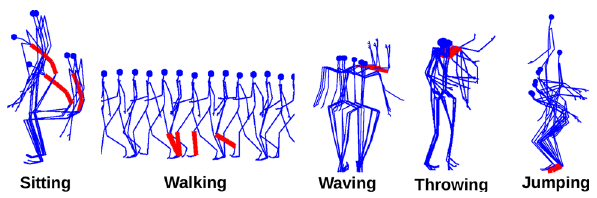
Fig. 9 Visualization of the Abs-filters learned by DACNN on the NTU dataset and the classes to which they are mostly related. Red links indicate the body parts in which the Abs-filters have high align- ment values